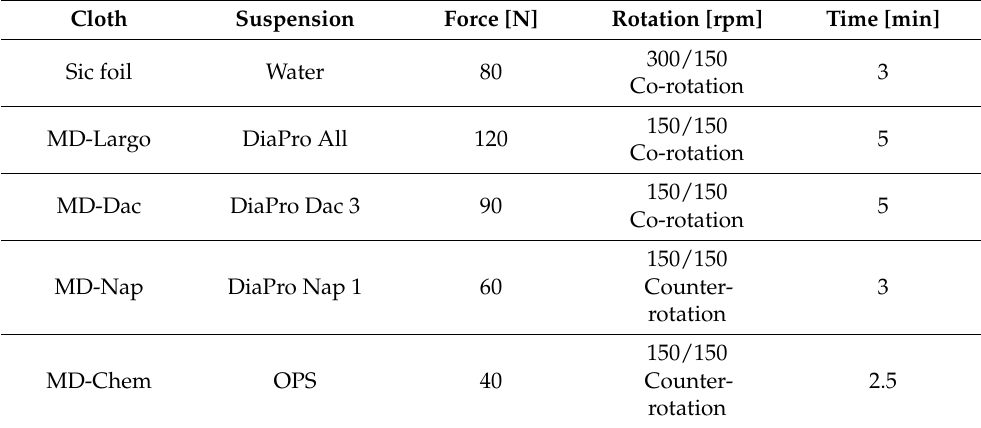
Table 3. Surface preparation sequence of G379 for nanoindentation.